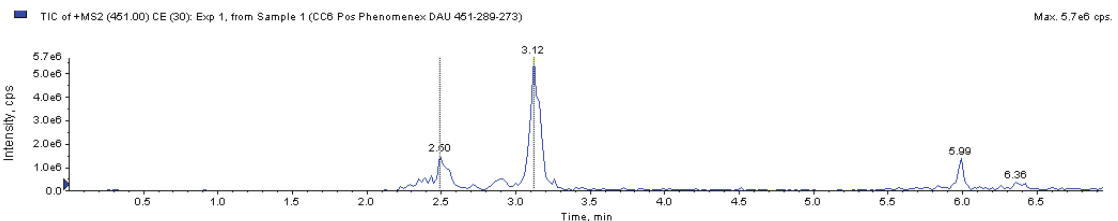
Figure 3. Chromatogram recorded for the fragmentation of ion [M+H] + =451, at 30 eV collision energy (ESI, positive).